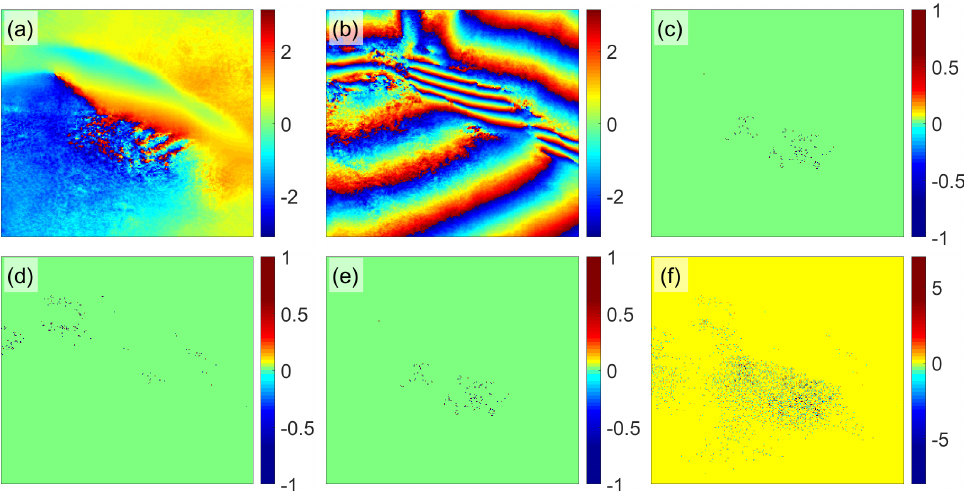
Figure 2. ( a , b ) TerraSAR-X interferogram with ( a ) short and ( b ) long baseline length. ( c , d ) The SB residue distributions of ( a , b ). ( e , f ) The MB residue distributions of ( a , b ) obtained by TSPA. Table 1. Statistical Information of Residue Distribution. SB MB Figure 2c Figure 2d Figure 2e Figure